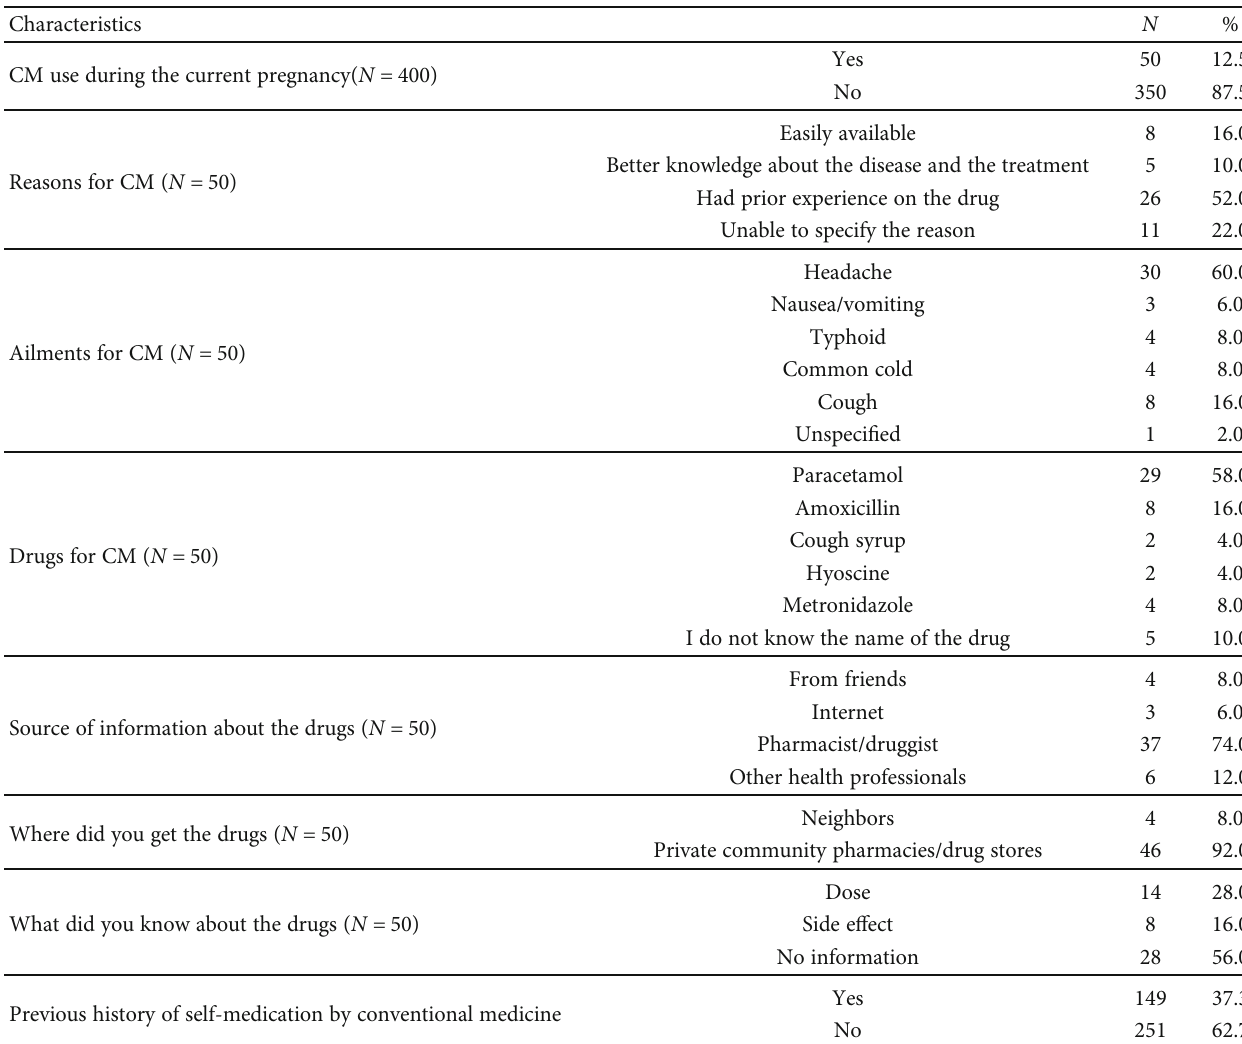
Table 4: Self-medication among pregnant women by conventional medicine at UoGCSH, June